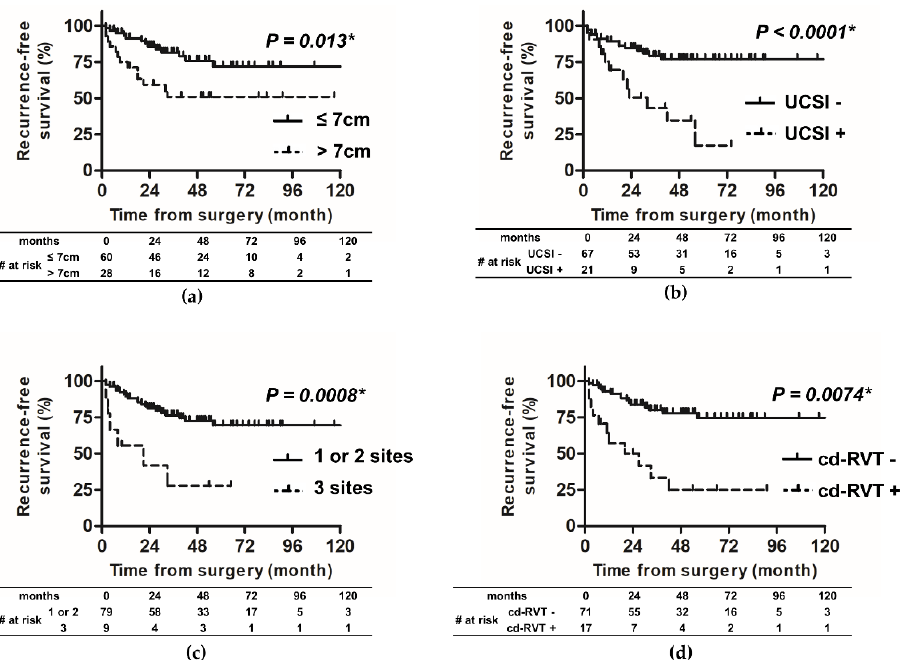
Figure 3. Recurrence ‐ free survival probabilities for four main factors; tumor size, urinary collecting system invasion, pathological invasion sites, and clinically detected renal vein thrombus. Patients with tumor size > 7 cm ( a ); UCSI ( b ); three invasion sites ( c ); or cd ‐ RVT ( d ) had a significantly higher risk of recurrence than those without. RFS, recurrence ‐ free survival; UCSI, urinary collecting system invasion; cd ‐ RVT, clinically detected renal vein thrombus.